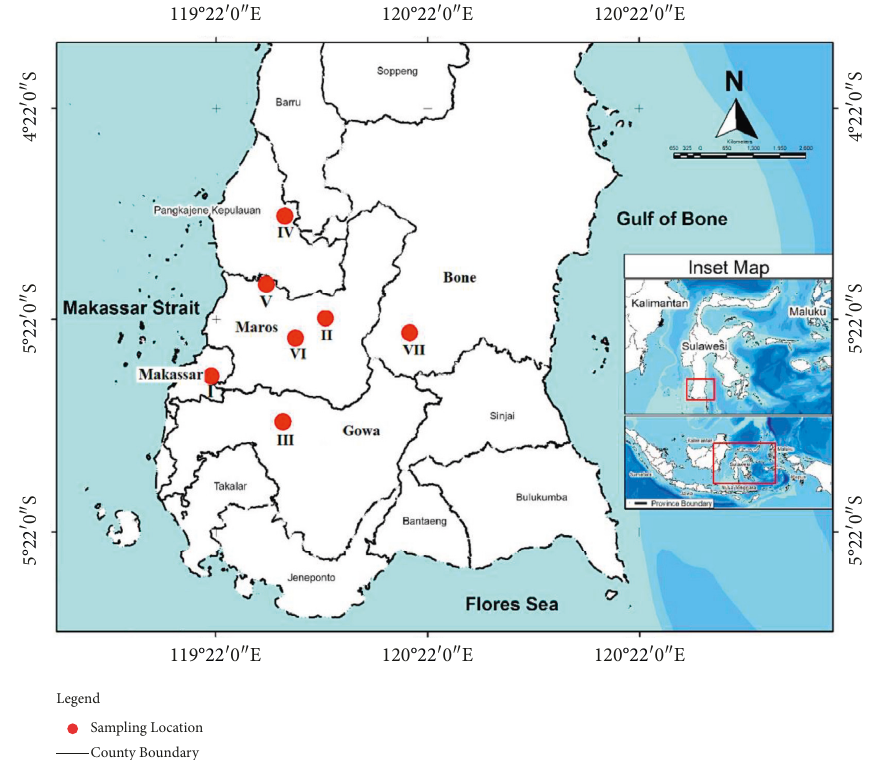
Figure 1: Sampling location (sites